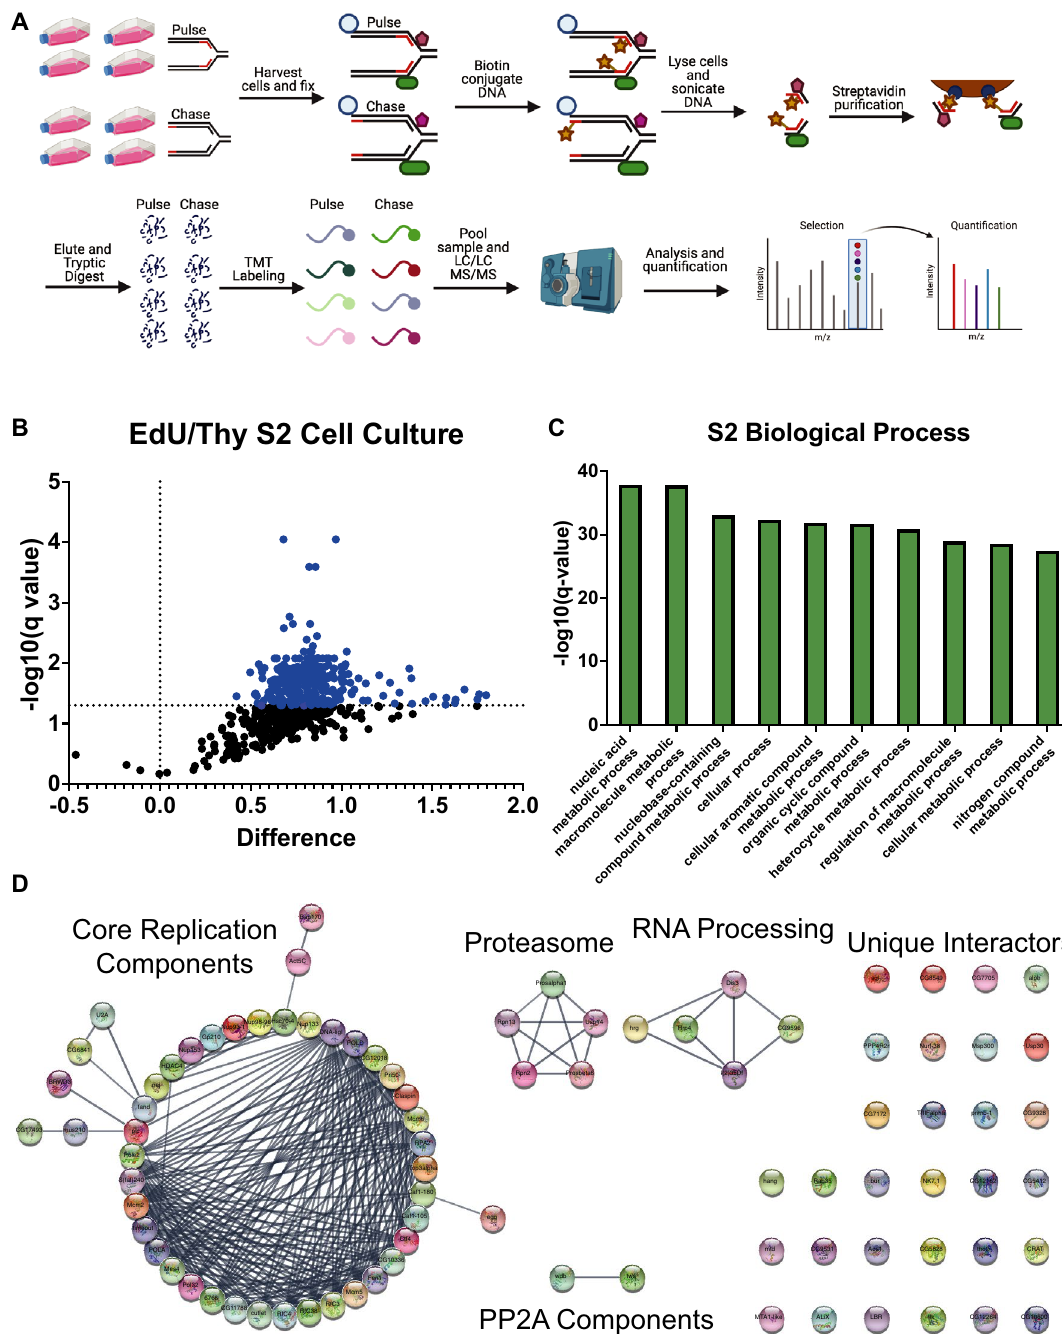
Figure 3. iPOND coupled to quantitative mass spectrometry in S2 cells. ( A ) A schematic of the labeling and mass spectrometry process for iPOND-TMT in Drosophila S2 cells. ( B ) Volcano plot visualizing those proteins identified as enriched or depleted in the pulse versus the chase cell culture samples. Enrichment (log2[pulse]- log 2 [chase]) on the X-axis and − log 10 (p-value) on the Y-axis. ( C ) The top 10 enriched biological processes of the proteins enriched in the pulse sample as determined by Gene Ontology (GO) analysis. ( D ) Network map of the proteins enriched in the pulse sample, clustered into groups of known interactors using the STRING database with no additional interactors added. For visualization, we included proteins with a corrected p value of < 0.05 and a > 1.8-fold fold enrichment (99 total proteins). The full list of enriched interactors can be found in Supplemental Table